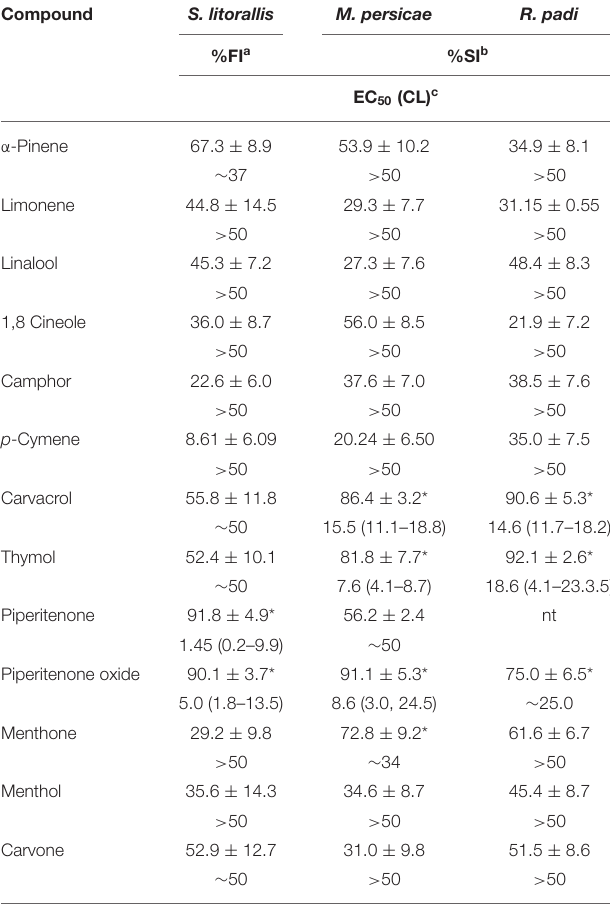
TABLE 7 | Antifeedant activity of the main components (% abundance > 10) of the active essential oils on Spodoptera littoralis larvae, Myzus persicae , and Rhopaslosiphum padi apterous adults in choice